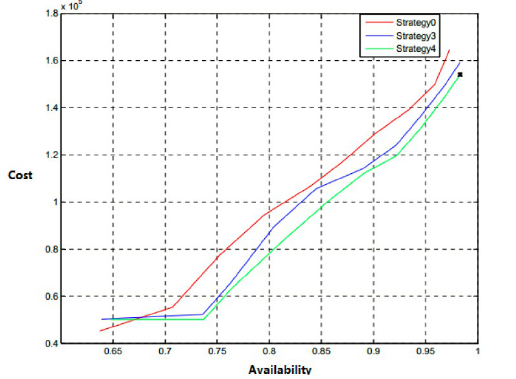
Figure 17. Results of availability and all-in support